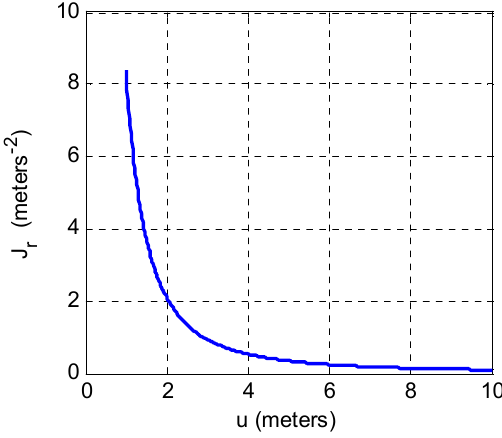
Figure 2. Fisher Information of a single RSS observation with σ r = 3